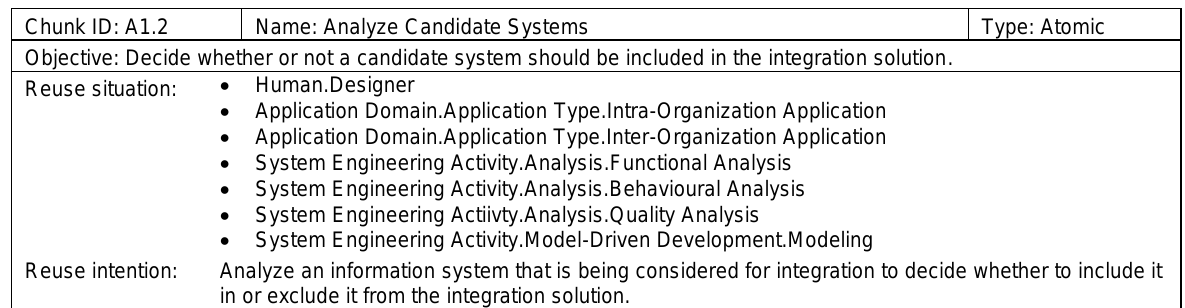
Table 2. Definition of method chunk